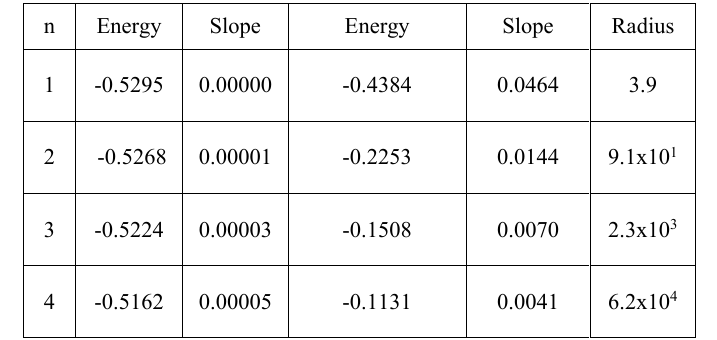
Table 1. Numerical result for Higgs mass regulator: the first two Columns are for the eigenvalues, slopes with fixed coupling constant and the last with running-coupling